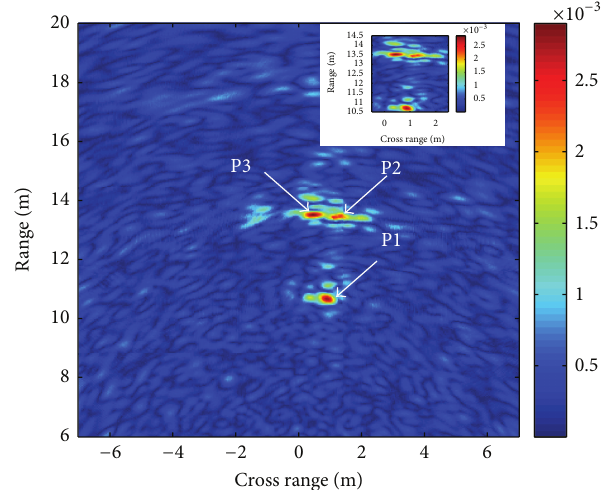
Figure 10: The original moving target imaging result.